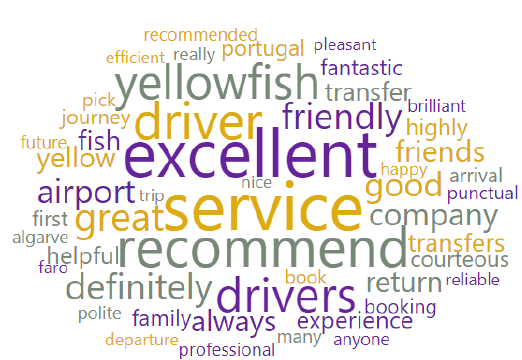
Figure 4. Word cloud results .